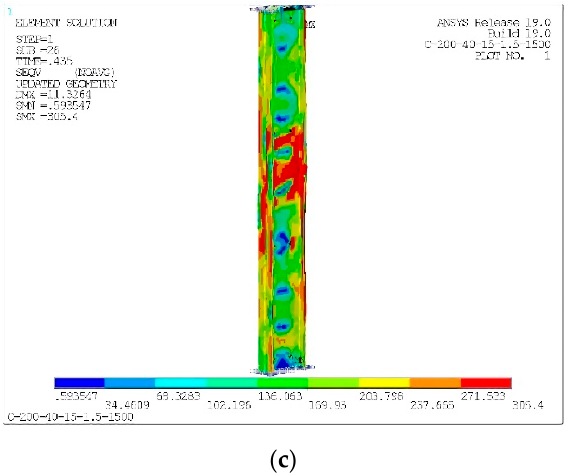
Figure 11. Stress distortions of the combined columns with different height to thickness ratios of web